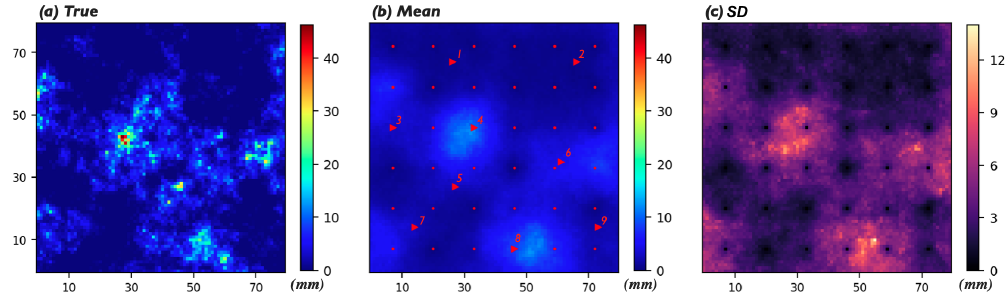
Figure 7. (a) The true rainfall field; (b) the mean of 100 realizations obtained from RM (the small red dots denote the locations of the rain gauges, and the red triangles labelled with IDs denote the 9px selected to develop the box and whisker plots shown in Fig. 8); (c) the standard deviation (std) of the 100 realizations.